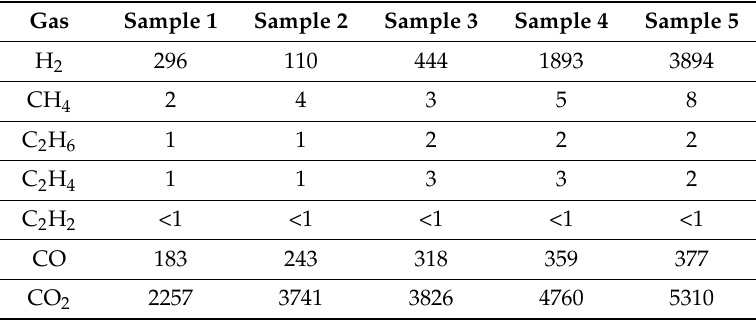
Table 6. DGA history of transformer 1.